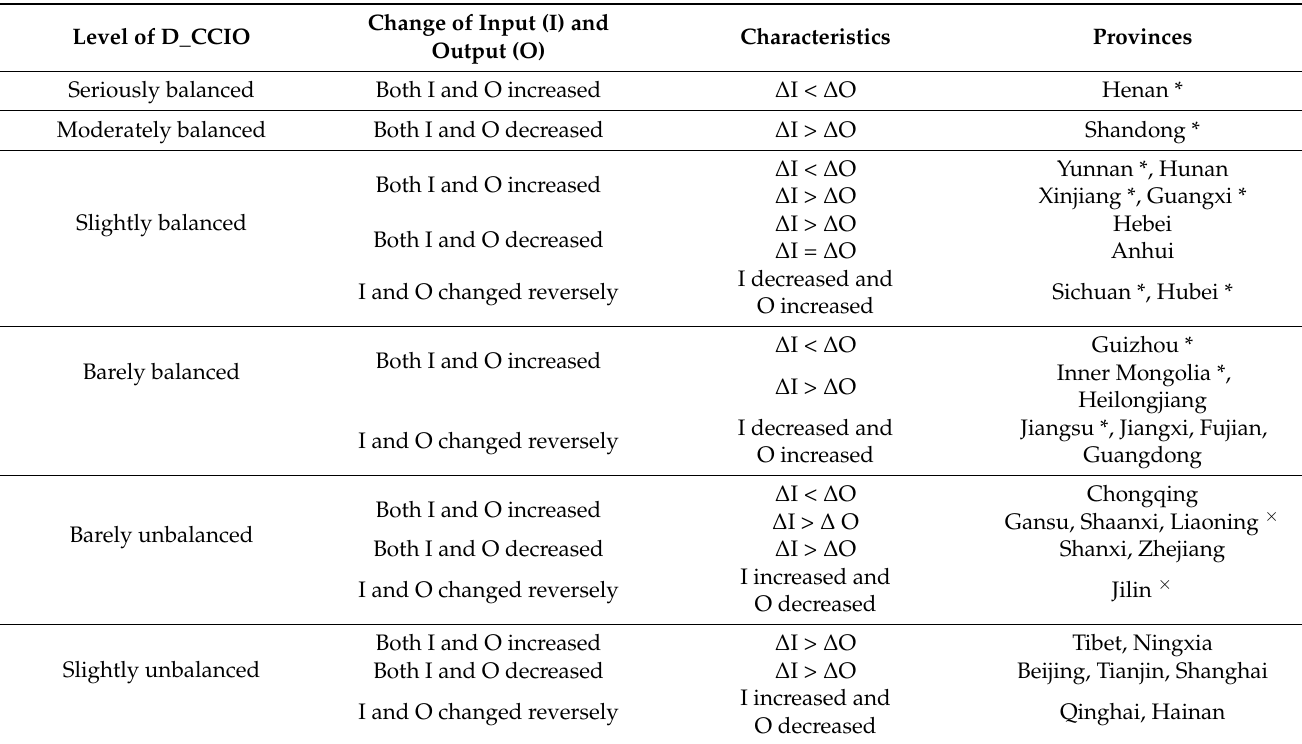
Table 3. Different changing mode of degree of coupling coordination between the input and output (D_CCIO) among the 31